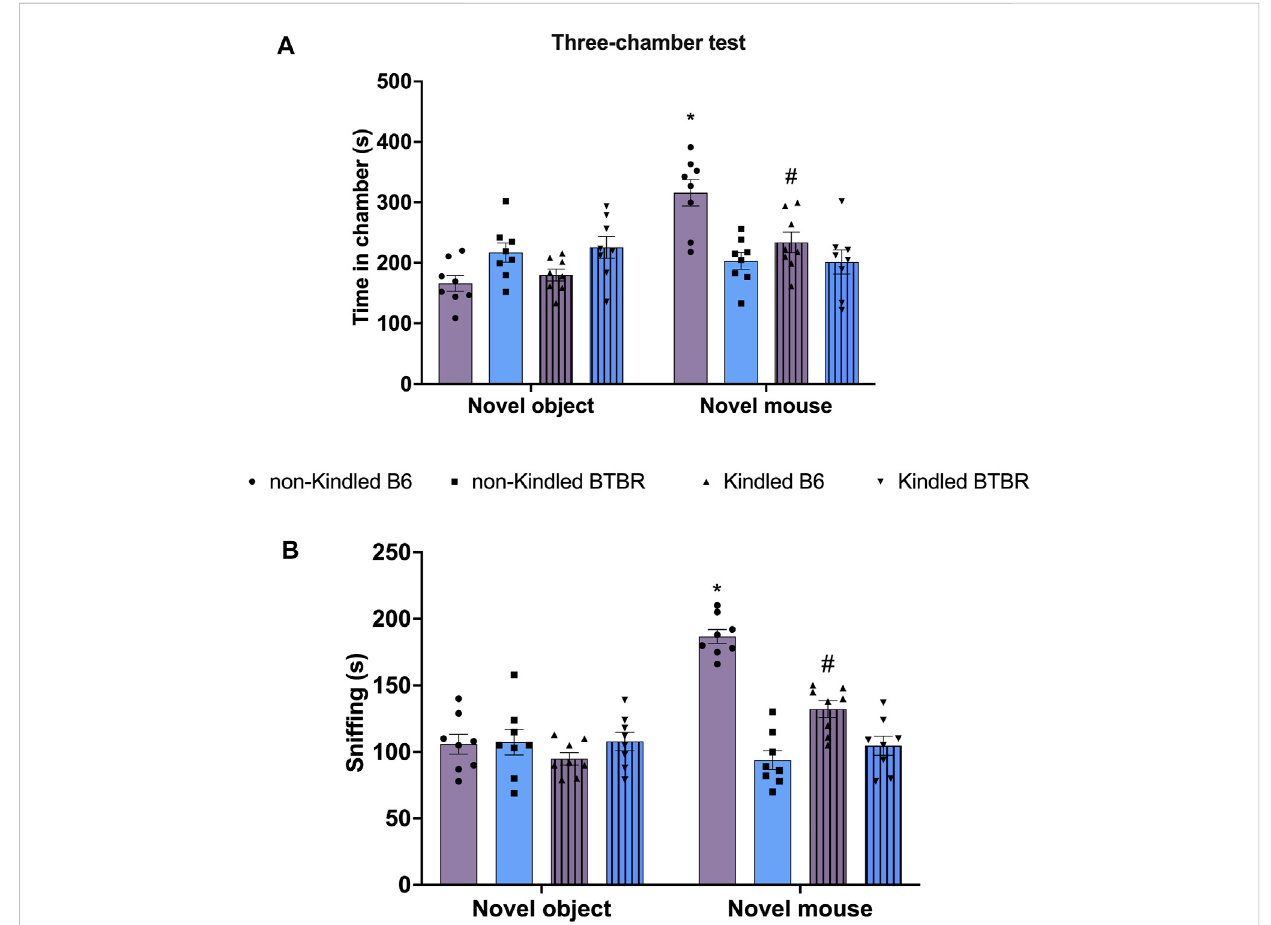
FIGURE 3 Three chamber social interaction test (TCT) performed at the end of the PTZ-kindling procedure. (A) Bars indicate the time (s) spent in the chamber containing the novel object and the time (s) spent in the novel mouse chamber. (B) Bars indicate the time (s) spent snif fi ng the novel mouse. Data are expressedasmean ± S.E.M. *Indicates p < 0.0001vs. novel object, # Indicates p < 0.05vs. non-kindledB6mice. B6 =C57BL/6J;